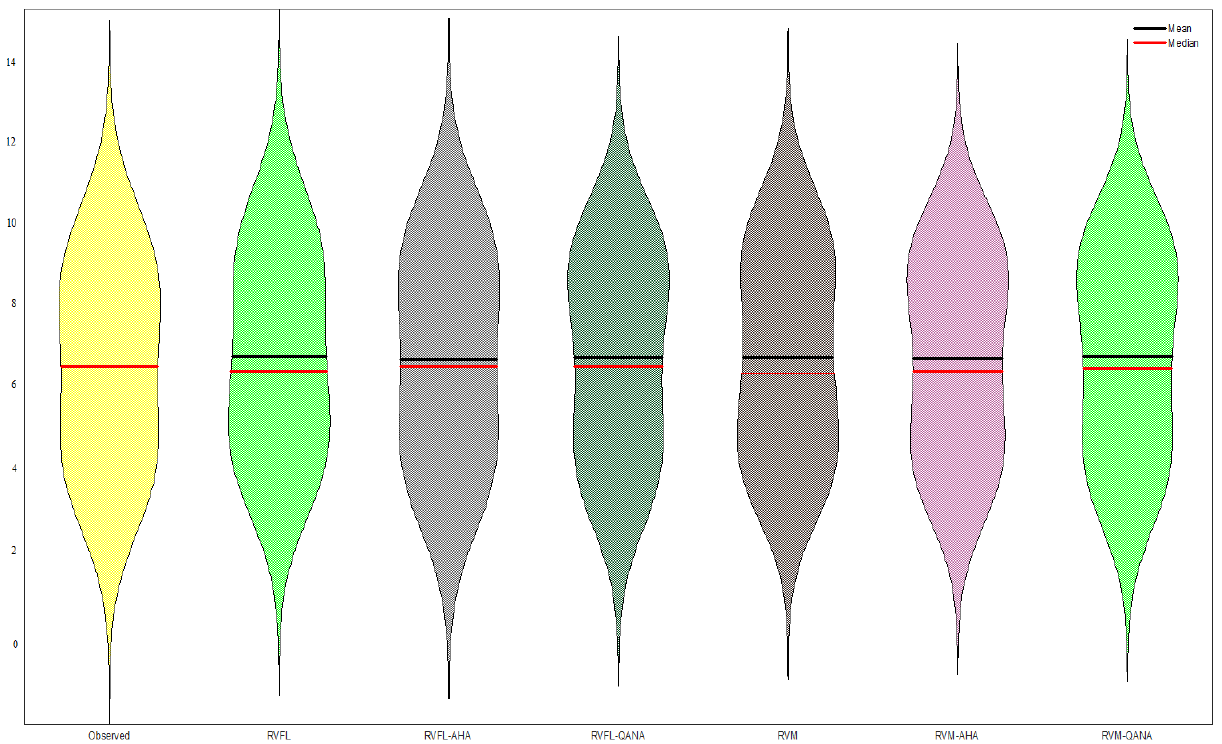
Figure 8. Violin charts of the predicted ET by different RVFL ‐ and RVM ‐ based models in the test period using the best input combination –Station 1 (Faisalabad).